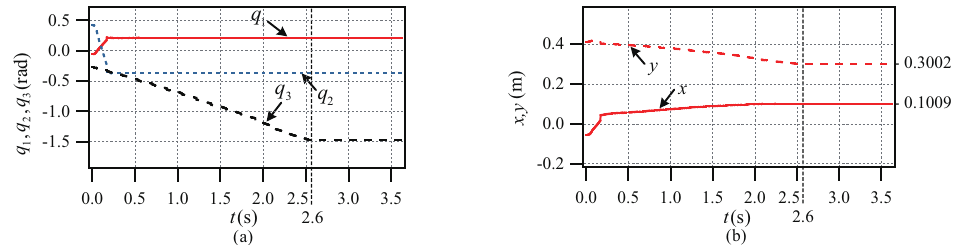
Figure 5. Experimental results of Case A: ( a ) angles of linkages, ( b ) coordinates of